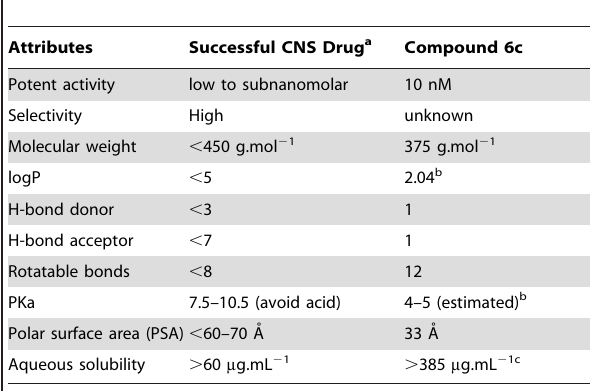
Table 2. Prediction of the ability to cross the BBB of CNS drugs using QSAR s